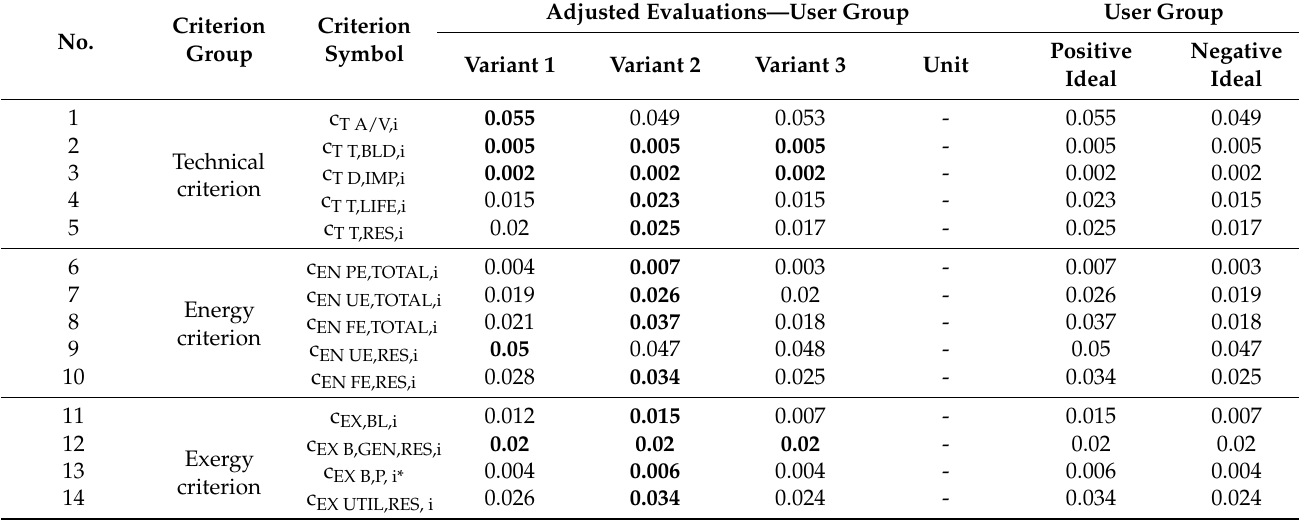
Table 11. Adjusted evaluations of the sub-criteria of evaluation for individual variants—the “Current/Future user” group.